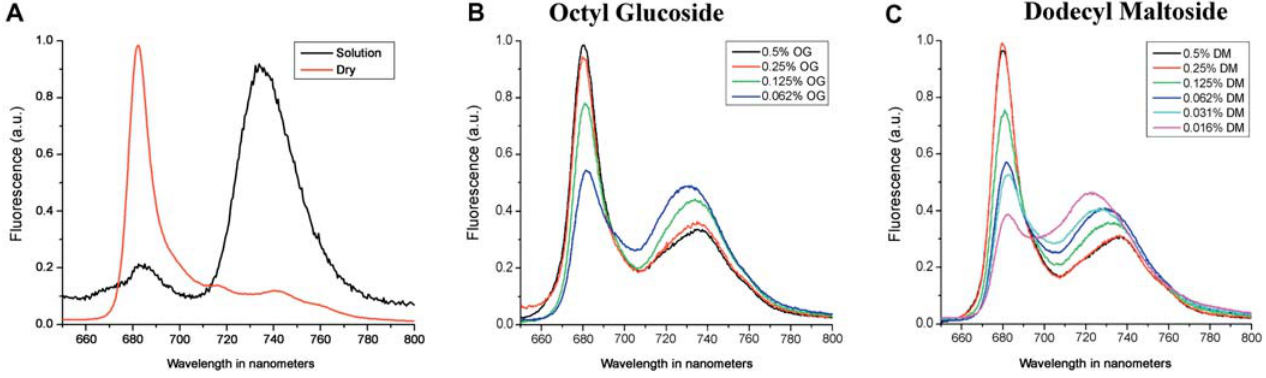
Figure 2. The (cid:1) 196.15 8 C Steady-State Emission Spectra of PS-I (A) The solution spectrum of PS-I shows characteristic far-red fluorescence at the approximately 735-nm region, while dried PS-I shows a peak at approximately 683 nm. (B) Emission spectra of samples containing DM retained partially their far-red fluorescence, but still showed a significant increase in fluorescence at approximately 683 nm. Additionally, the far-red fluorescence demonstrated a significant blueshift. (C) Comparable changes are evident in the spectra of samples containing OG as seen in DM (B). DOI: 10.1371/journal.pbio.0030230.g002 PLoS Biology |